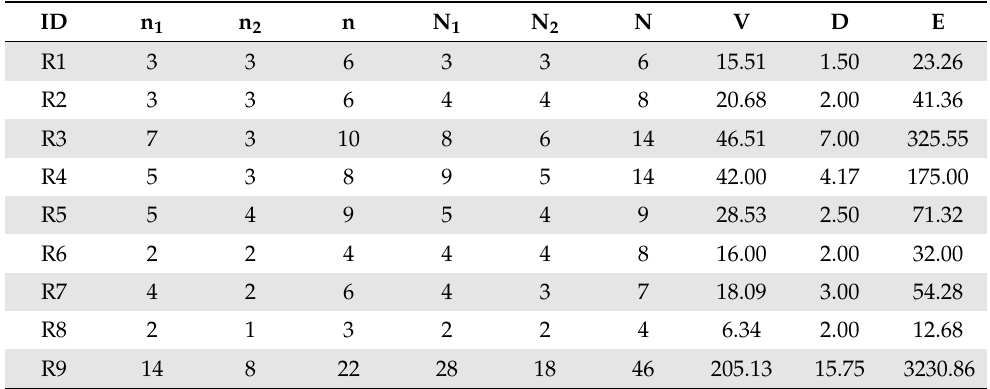
Table A14. Metrics calculations for eCRG